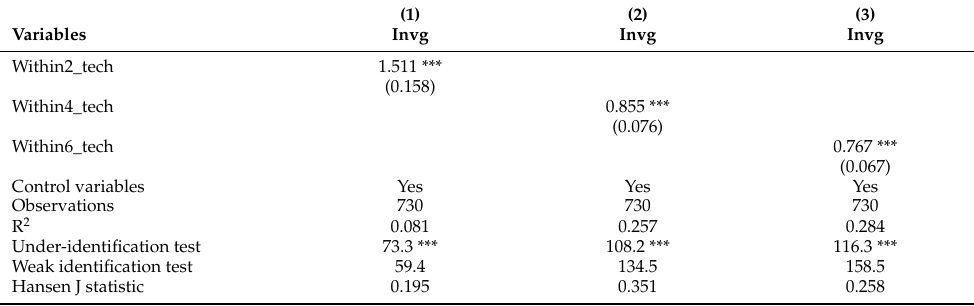
Table 4. IV model results explaining the impact of the proportion of government technology expenditure of the cities to that of the region by HSR rail within 2, 4, and 6 h on invention patents